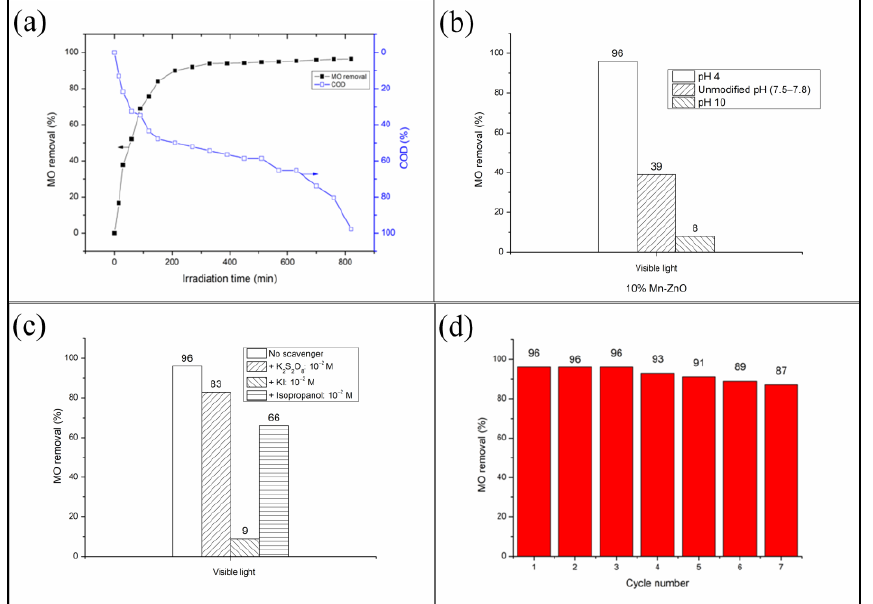
Figure 8. ( a ): COD and MO removal as a function of irradiation time. ( b ): pH effect on the MO removal. ( c ): Effect of adding of various active species scavengers on the MO removal. ( d ): Reusability of the nanoparticles under visible light. Photocatalyst: 10%Mn-ZnO, C 0 (MO) = 10 −5 M, m photocatalyst = 0.5 g L −1 , pH = 4.